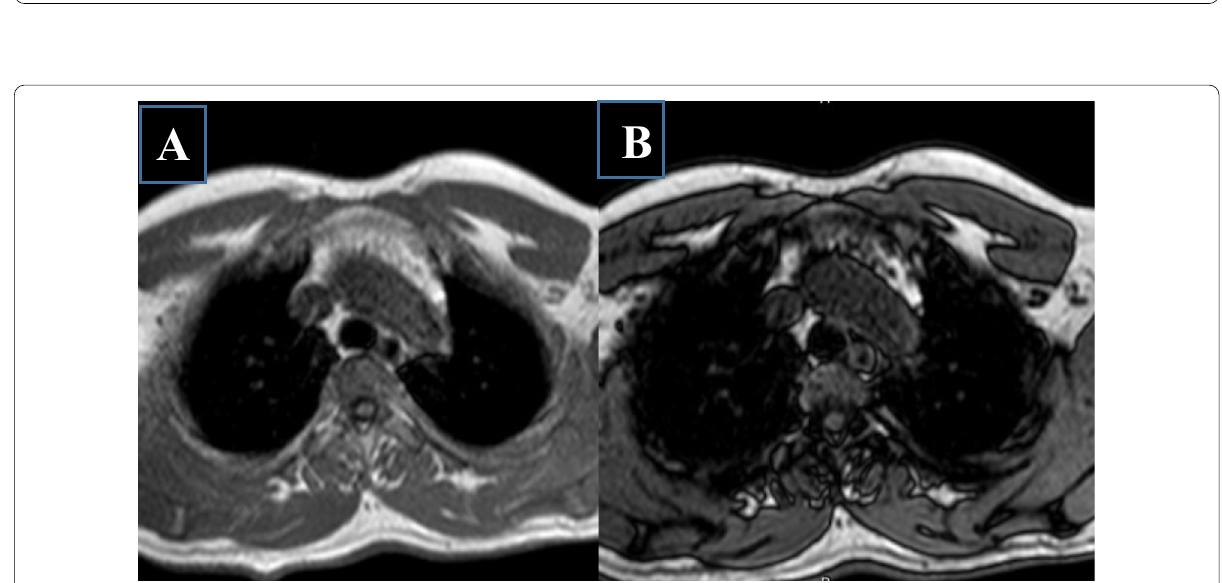
Fig. 6 MRI chemical shift imaging in a 34‑year‑old male patient complaining of dysphagia and weakness in both upper limbs diagnosed as MG. a In phase and b out of phase MR images show the lesion eliciting a hyperintense signal relative to the surrounding muscles in the in‑phase series with apparent signal drop in the out of phase series. CSR value is 0.61. Histopathological diagnosis was thymic